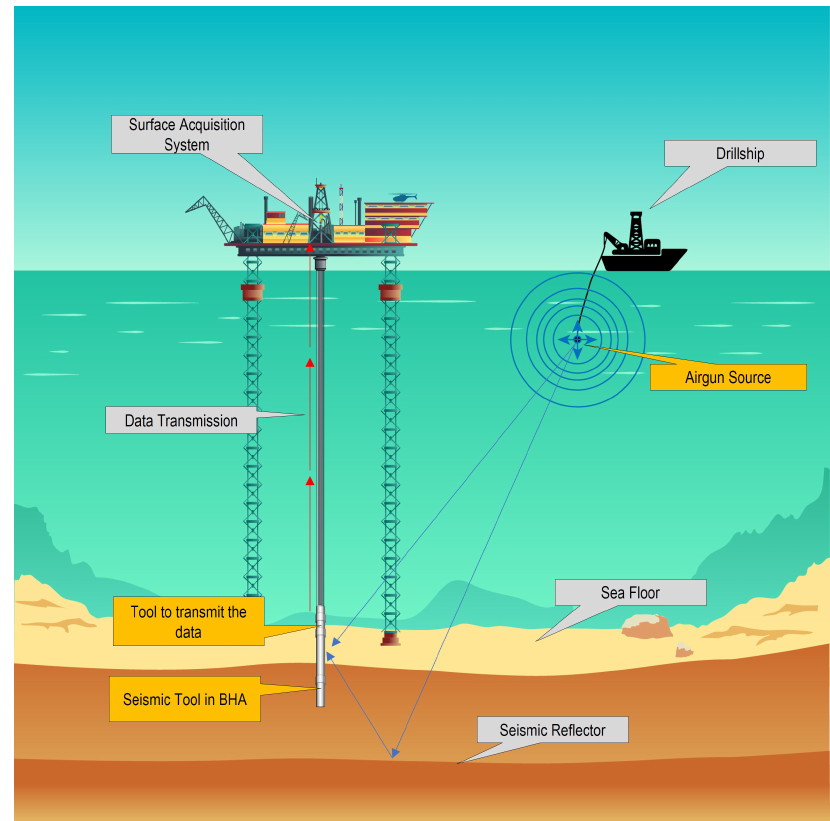
Figure 14. The seismic-guided drilling technology—based on the concept described in